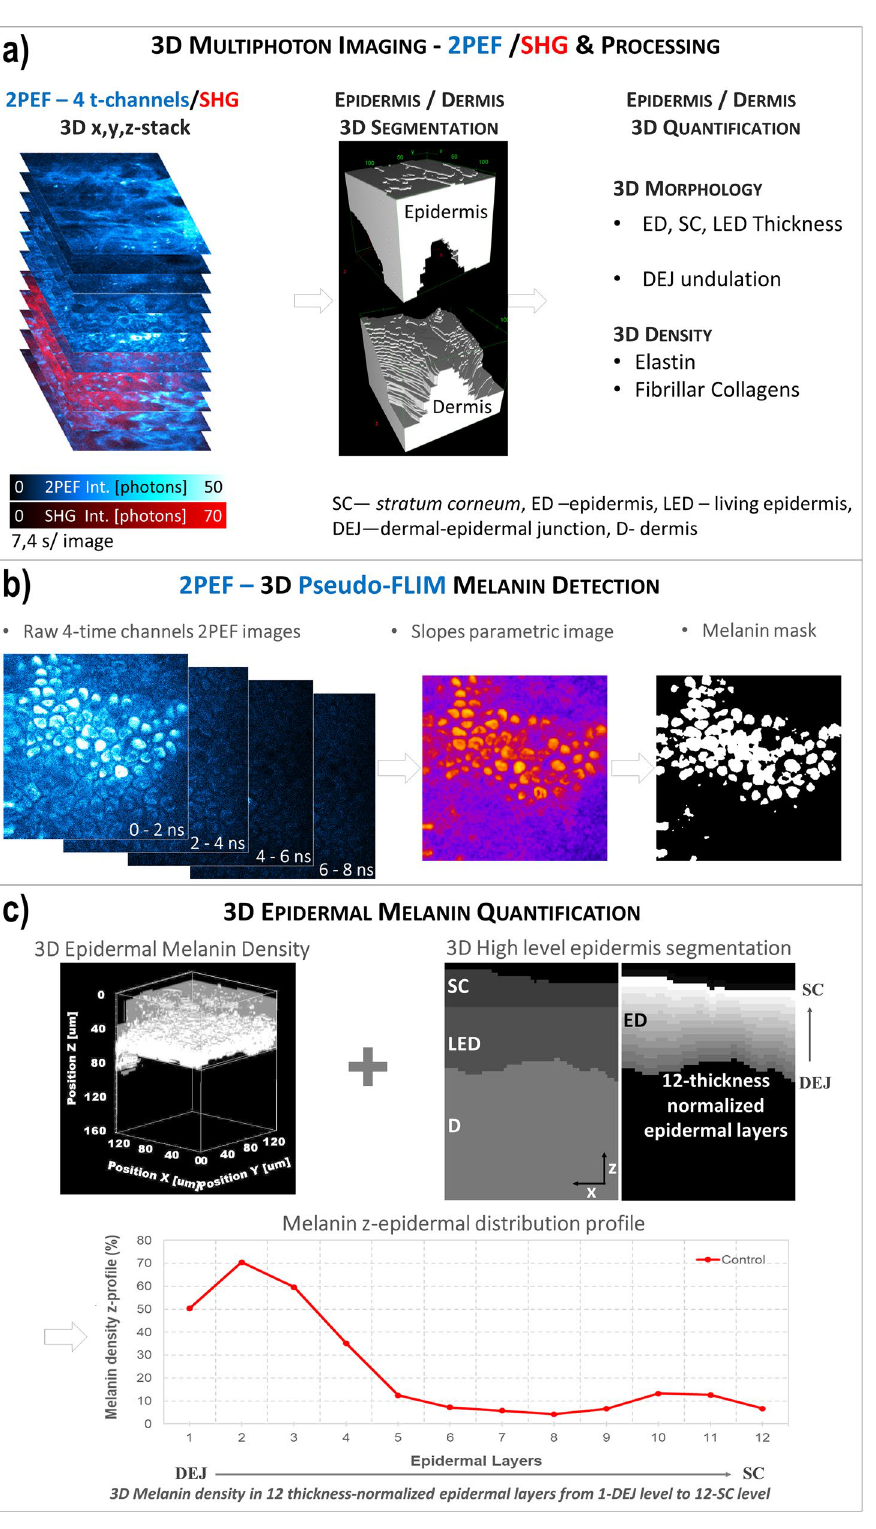
Figure 2. Global analysis process for in vivo 3D multiphoton images allowing 3D skin automatic layers segmentation and constituents quantification. ( a ) The first step of global 3D analysis of z-stacks of combined 2PEF-FLIM (4 time channels)/SHG images briefly consists in identifying the epidermal and dermal layers (3D automatic segmentation) and quantifying their morphology (thickness, DEJ 3D-shape) and the 3D dermal density of elastin and fibrillar collagens. ( b ) The z-stack of 2PEF-FLIM (4 time channels) images is further processed for melanin detection using Pseudo-FLIM method. The first 3-time channels are used for slope parametric image calculation and a melanin mask is obtained by applying a threshold to keep the high slopes values (above 70). ( c ) The 3D z-stack of melanin masks and the 3D automatic segmentation of the epidermis and its sub-layers are jointly used to estimate a 3D epidermal, SC or LED melanin density. By defining 12-thickness normalized epidermal layers, the epidermal melanin density z-distribution (z-profile of melanin density in the 12 thickness-normalized epidermal layers from 1—DEJ level to 12—SC level) can be